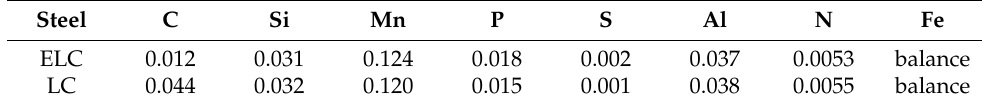
Table 1. Chemical composition of investigated materials (mass fraction, %).